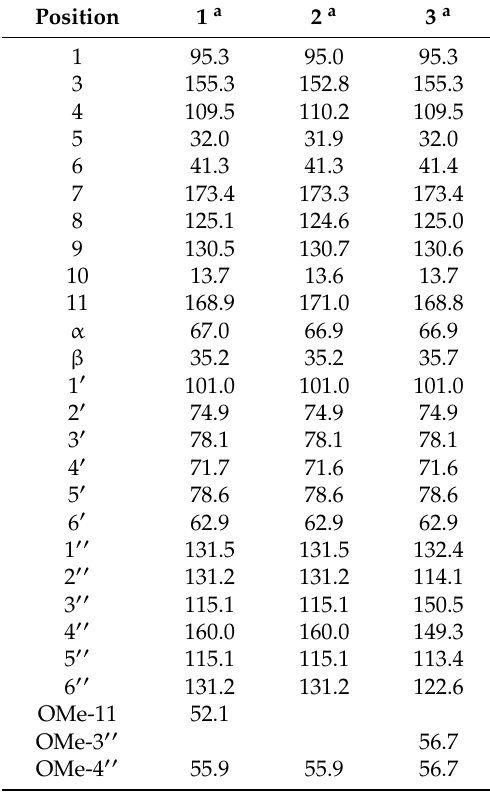
Table 2. 13 C-NMR data for compounds 1 – 3 ( δ in ppm).